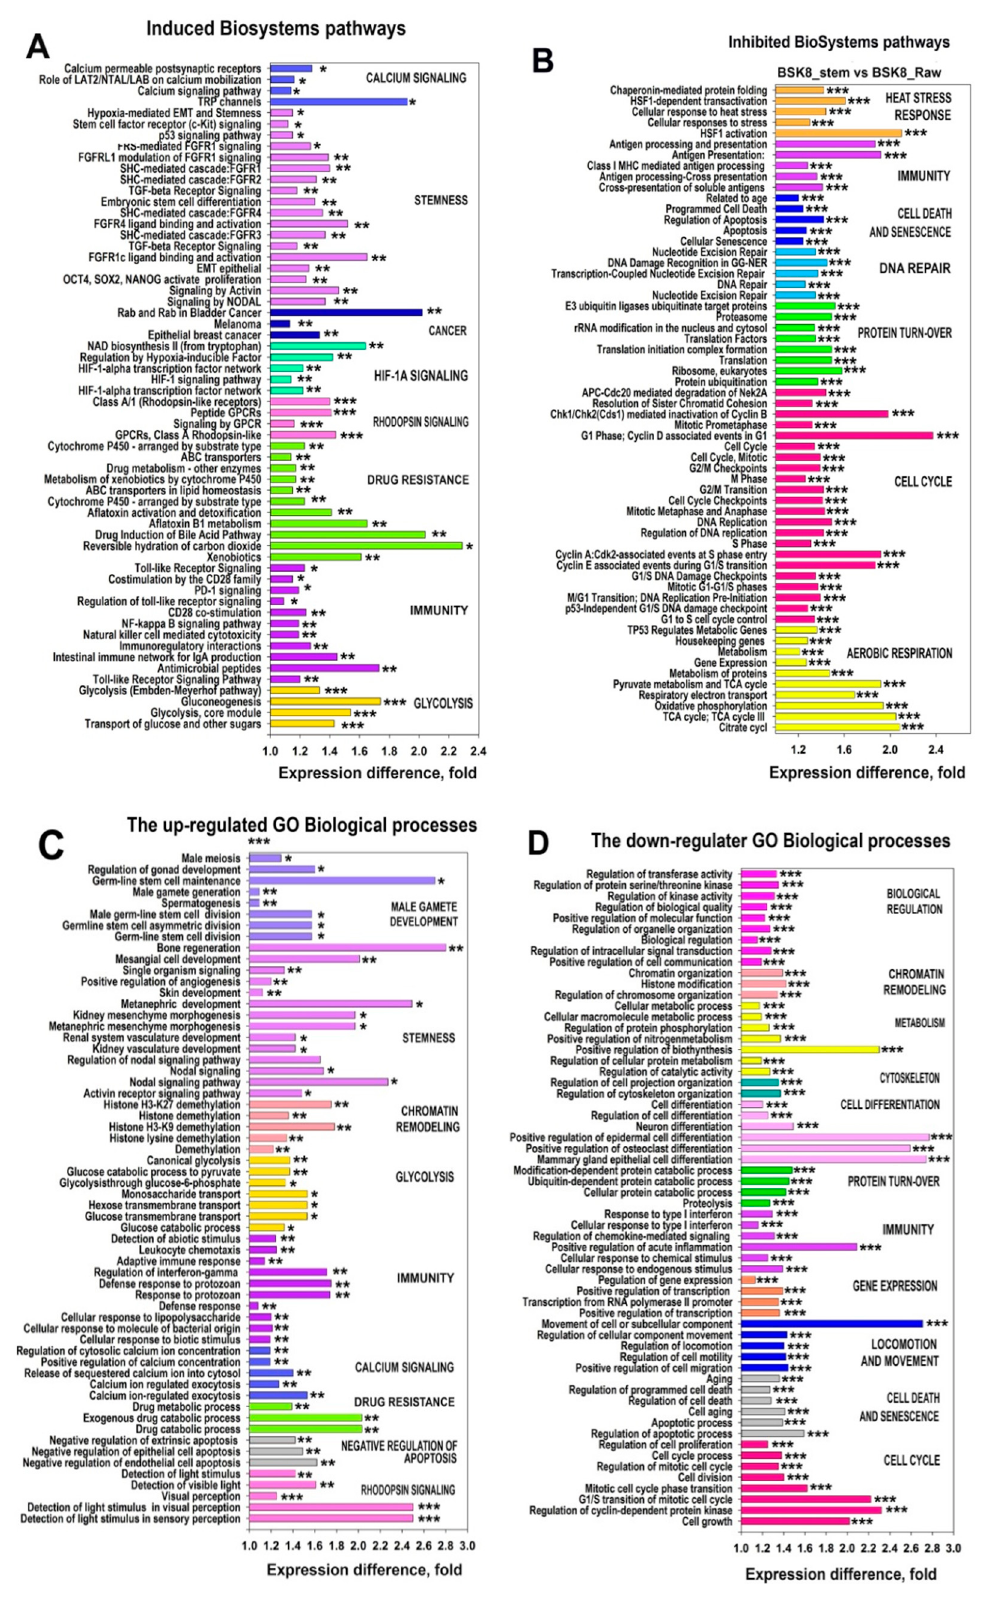
Figure 8. 60 most significantly up-regulated ( A , C ) and down-regulated ( B , D ) GO Biological processes and NCBI BioSystems pathways in the CSC-like cell line vs the original population of the BSC8 cell line. Gene modules with similar functions are marked with the same color. * q < 0.05; ** q < 0.01; *** q < 0.001.